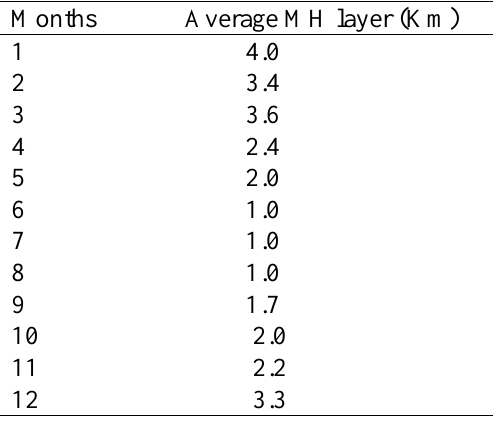
Table 3. MH layer in the